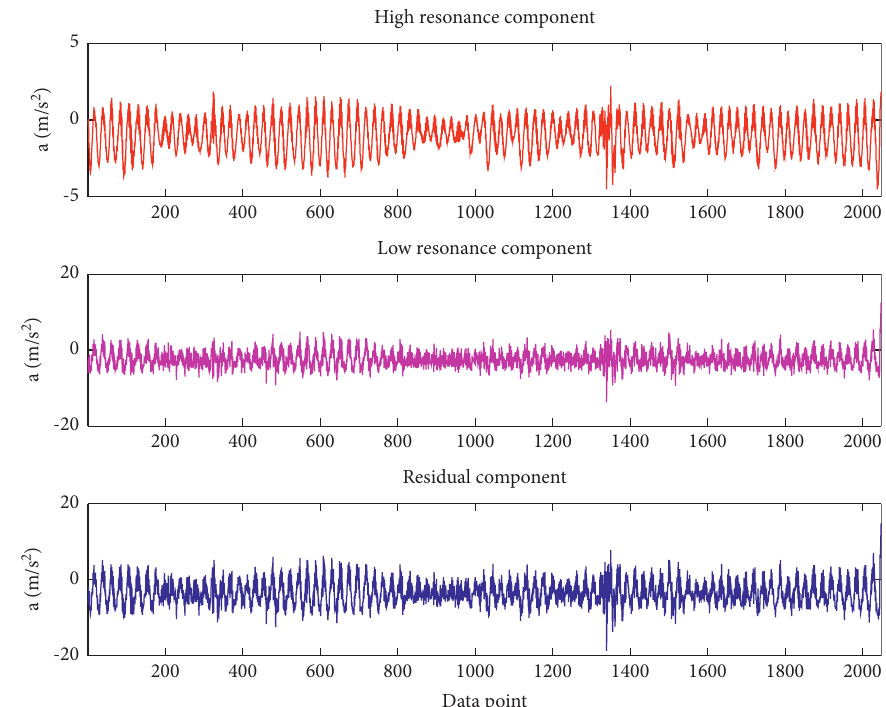
Figure 19: The RSSD decomposition result of vibration signal nor.